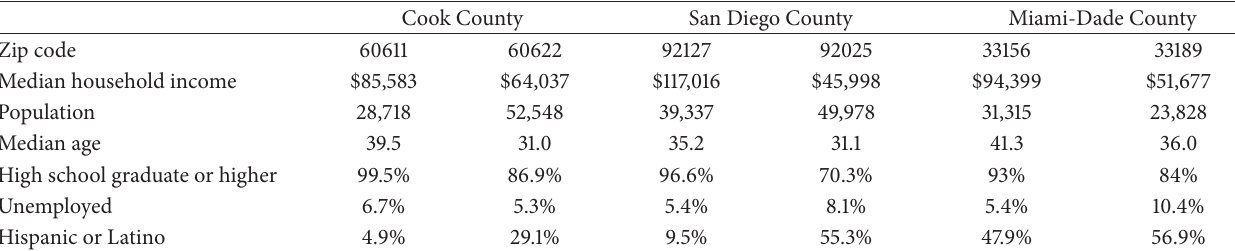
Table 1: Demographics of selected zip codes.